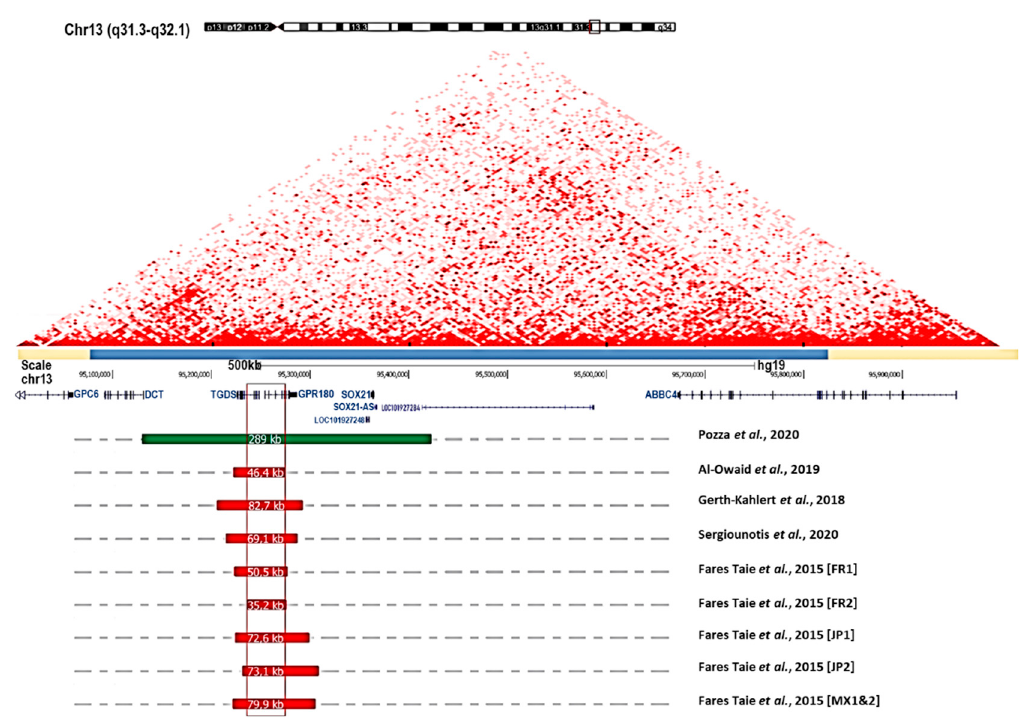
Figure 3. Summary of 13q32.1 structural variations associated with congenital microcoria. The two-dimensional heat map representing normalized Hi-C sequencing visualization in HMEC with the 3D Genome Browser is shown [72]. The topologically associating domain (TAD) encompassing the MCOR region and spanning 600 kb is indicated with a light blue bar (chr13:95,075,000–95,825,000, Hg19 and 5 kb resolution). Gene organization at chromosome 13q32.1, and position and size of structural variations (deletions in red; duplication in green) reported in individuals suffering from congenital microcoria [7,31,32,67]. The critical deletion (shown in red frame) responsible for MCOR spans 31.8 kb (hg19, chr13: 95,241,606–95,273,292). The reciprocal duplication encompasses 7 genes: DCT, TGDS, GPR180, LOC101927248, SOX21, SOX21-AS , and LOC101927284 [12].